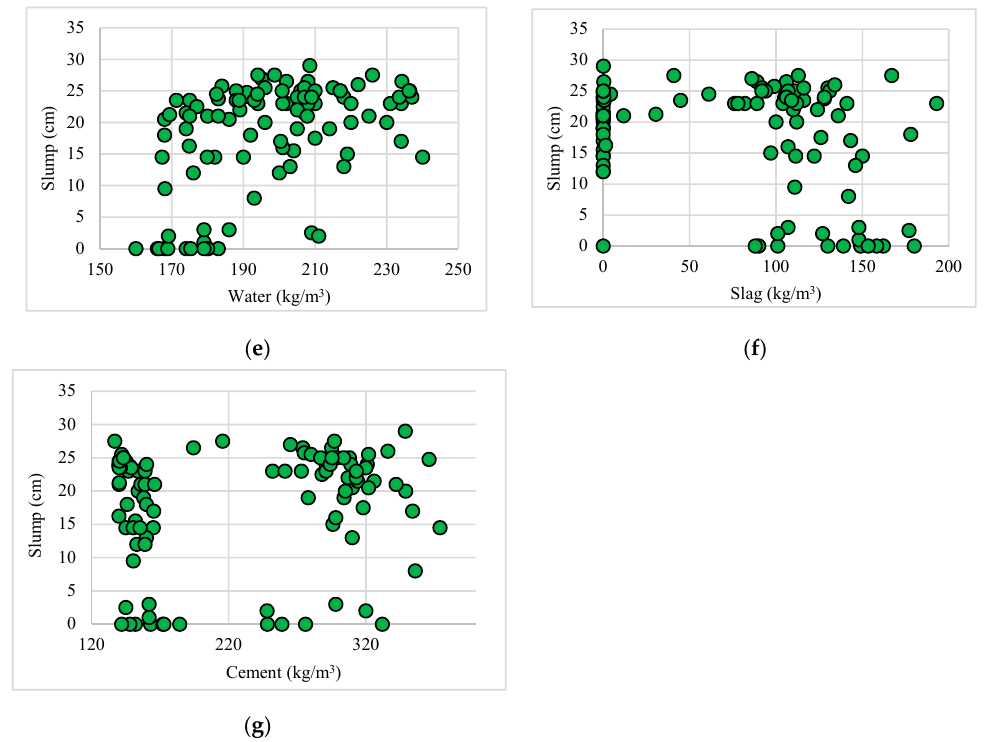
Figure 4. The graphical description of the concrete slump influential factors. ( a ) FA (kg/m 3 ), ( b ) CA (kg/m 3 ), ( c ) SP (kg/m 3 ), ( d ) Fly ash (kg/m 3 ), ( e ) Water (kg/m 3 ), ( f ) Slag (kg/m 3 ), ( g ) Cement (kg/m 3 )